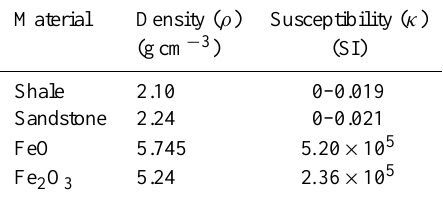
Table 1. Density and susceptibility of rocks and iron